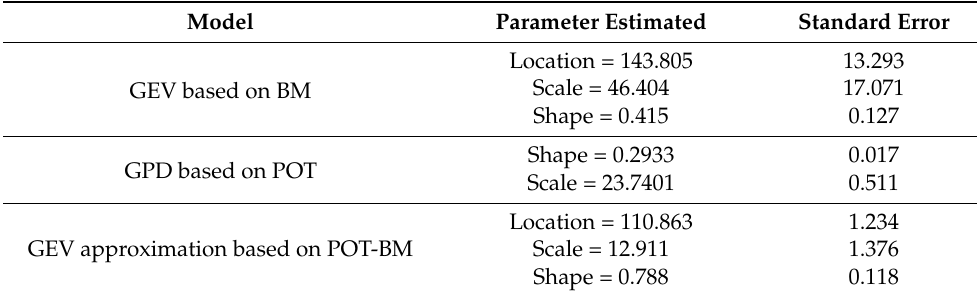
Figure 4. MRL plot corresponding to threshold u = 100. Table 3. Results of parameter estimation for each fitted extreme-value model.